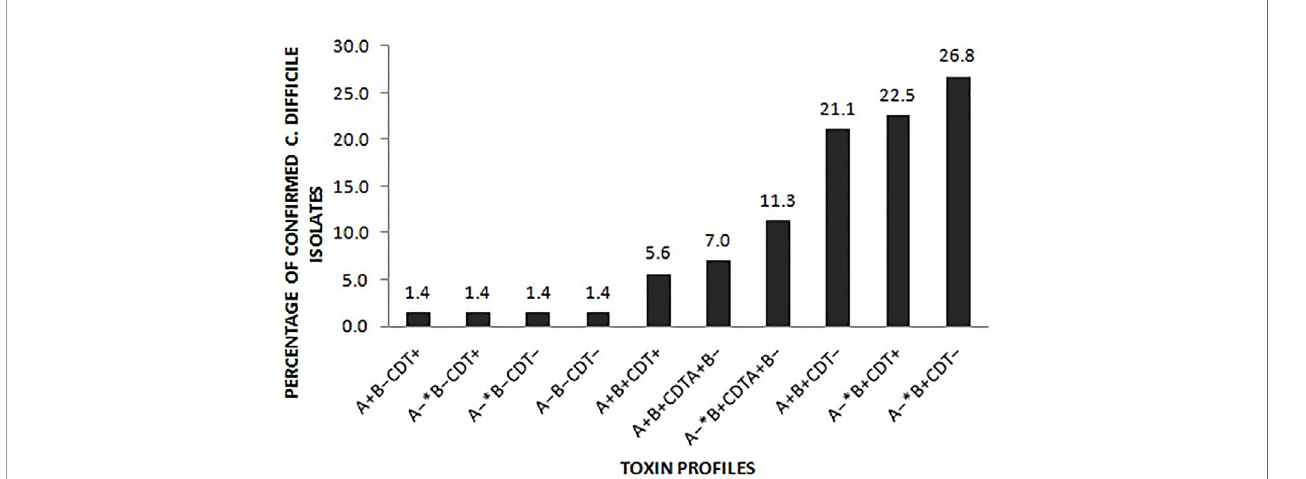
FIGURE 1 | Distribution of the toxin types of the 71 C . dif fi cile isolates. A − *: isolates in which the tcdA gene had a 110 bp deletion compared to the wildtype tcdA gene. CDT + : isolates harboured both cdtA and cdtB gene of the binary toxin. CDTA + B − : isolates only harboured the A component of the binary toxin. CDT – isolates lacked either of the binary toxin genes.